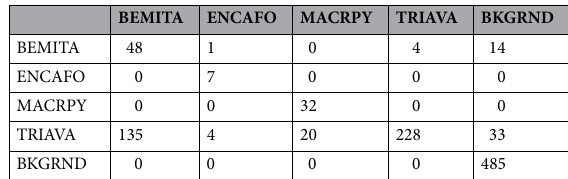
Table 6. Confusion matrix for model 164 tested on the GH0d-7d image set.